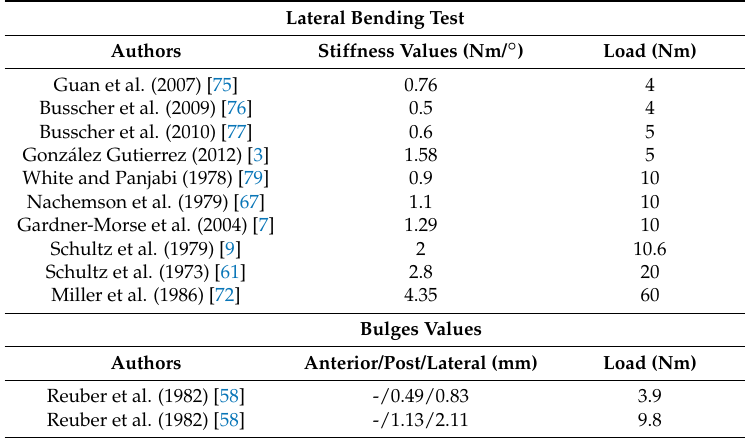
Table 4. Stiffness values and lateral bending loads from various